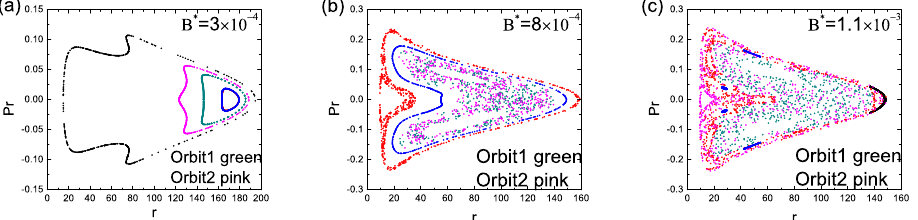
Figure 7. Poincaré sections. The magnetic field parameters are ( a ) B* = 0.0003, ( b ) B* = 0.0008 and ( c ) B* = 0.0011. The parameters are E = 0.995, L = 4.6, a = 0.5, and Q ∗ = 0.0003. Orbits 1 and 2 have their initial separations r = 75 and r = 100, respectively. The initial separations are r = 15 for the black orbit, r = 35 for the red orbit, and r = 55 for the blue orbit.